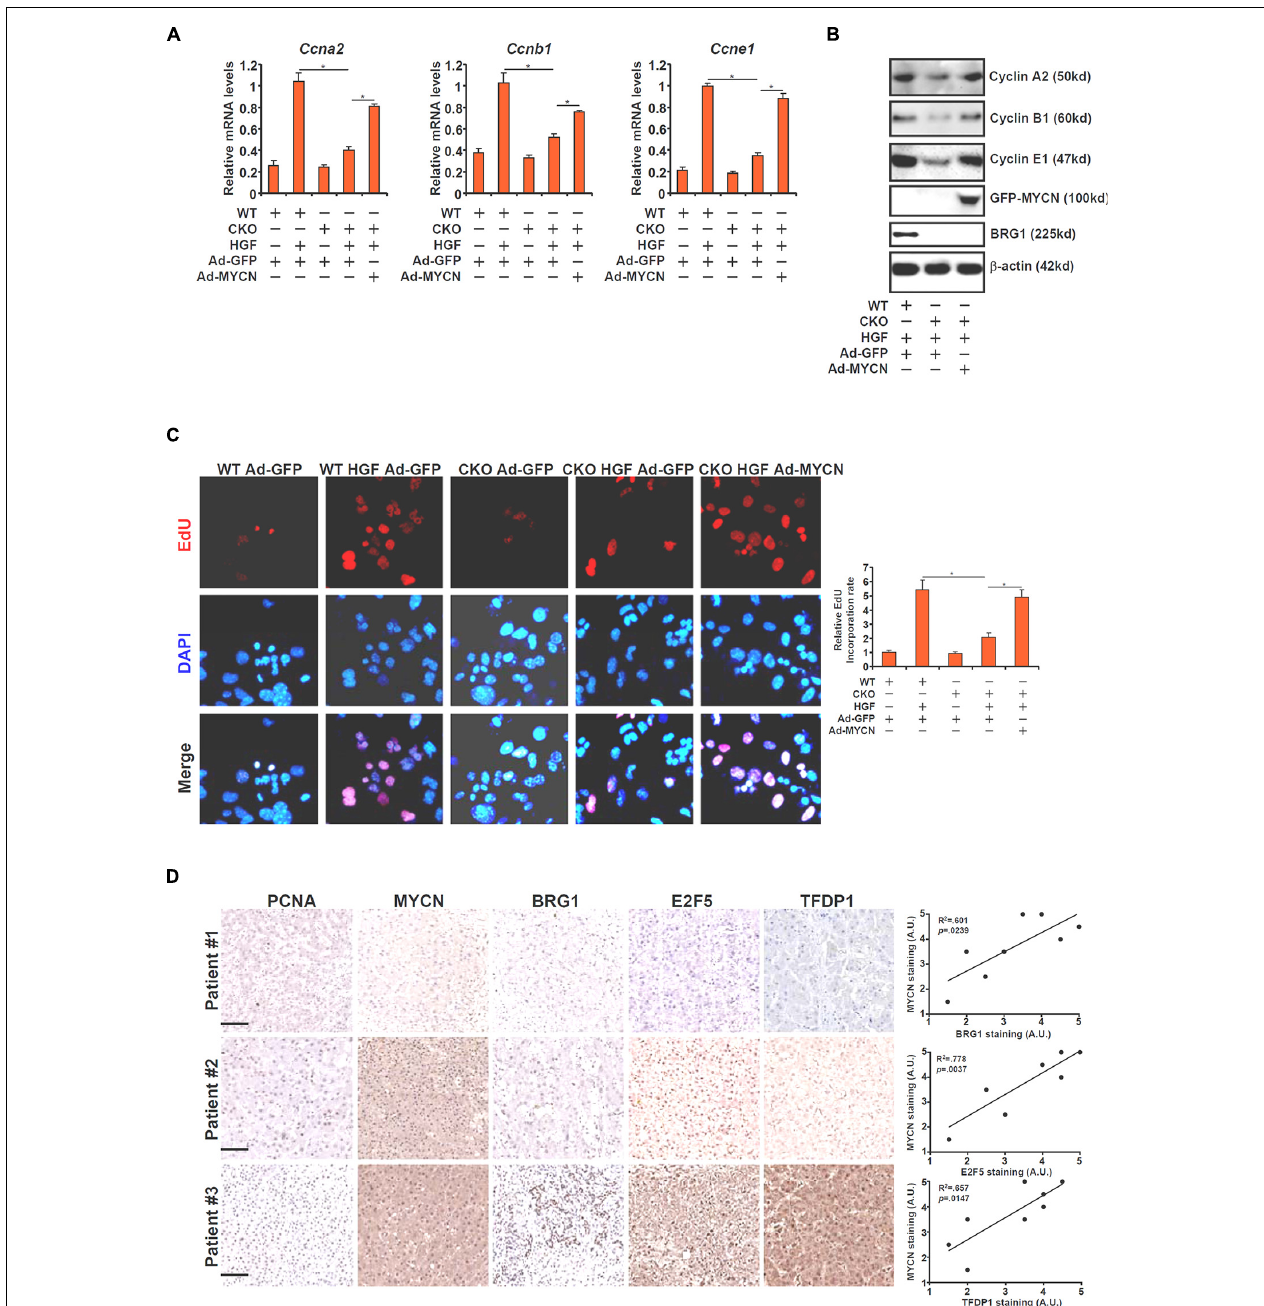
FIGURE 5 | MYCN over-expression overcomes BRG1 deficiency and normalizes hepatocyte proliferation. (A–C) Primary hepatocytes were isolated from WT and BRG1 CKO mice and transduced with adenovirus carrying MYCN expression vector followed by treatment with HGF. Gene expression levels were examined by qPCR and Western. Cell proliferation was measured by EdU staining. (D) Human ALF specimens were stained with indicated antibodies. Linear regression was performed with Graphpad Prism. Data are expressed as mean ± standard deviation (SD). * p < 0.05 (one-way ANOVA with post hoc Scheffe